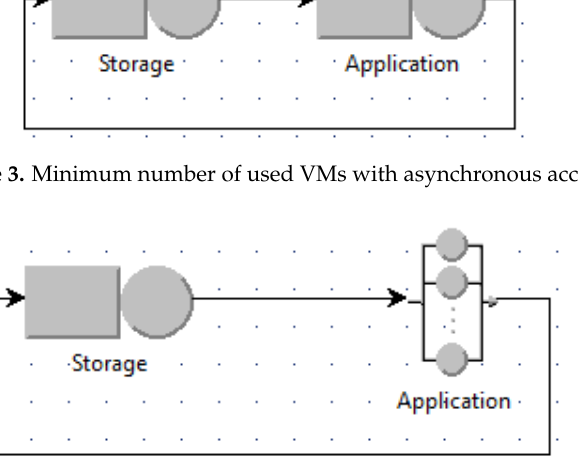
Figure 4. Maximum number of used VMs with asynchronous